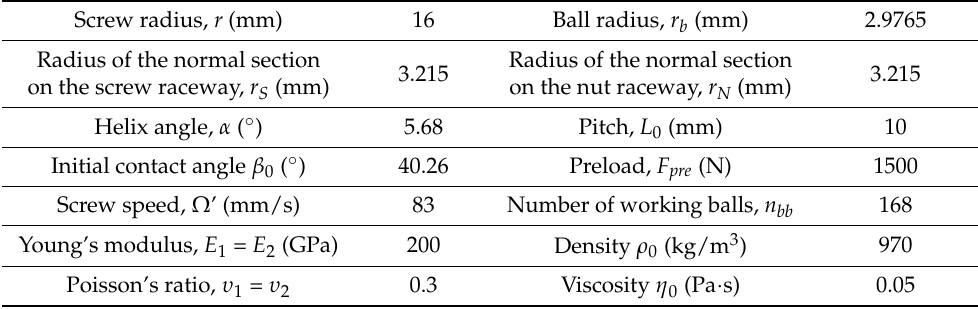
Table 1. Parameters of double-nut ball screws .